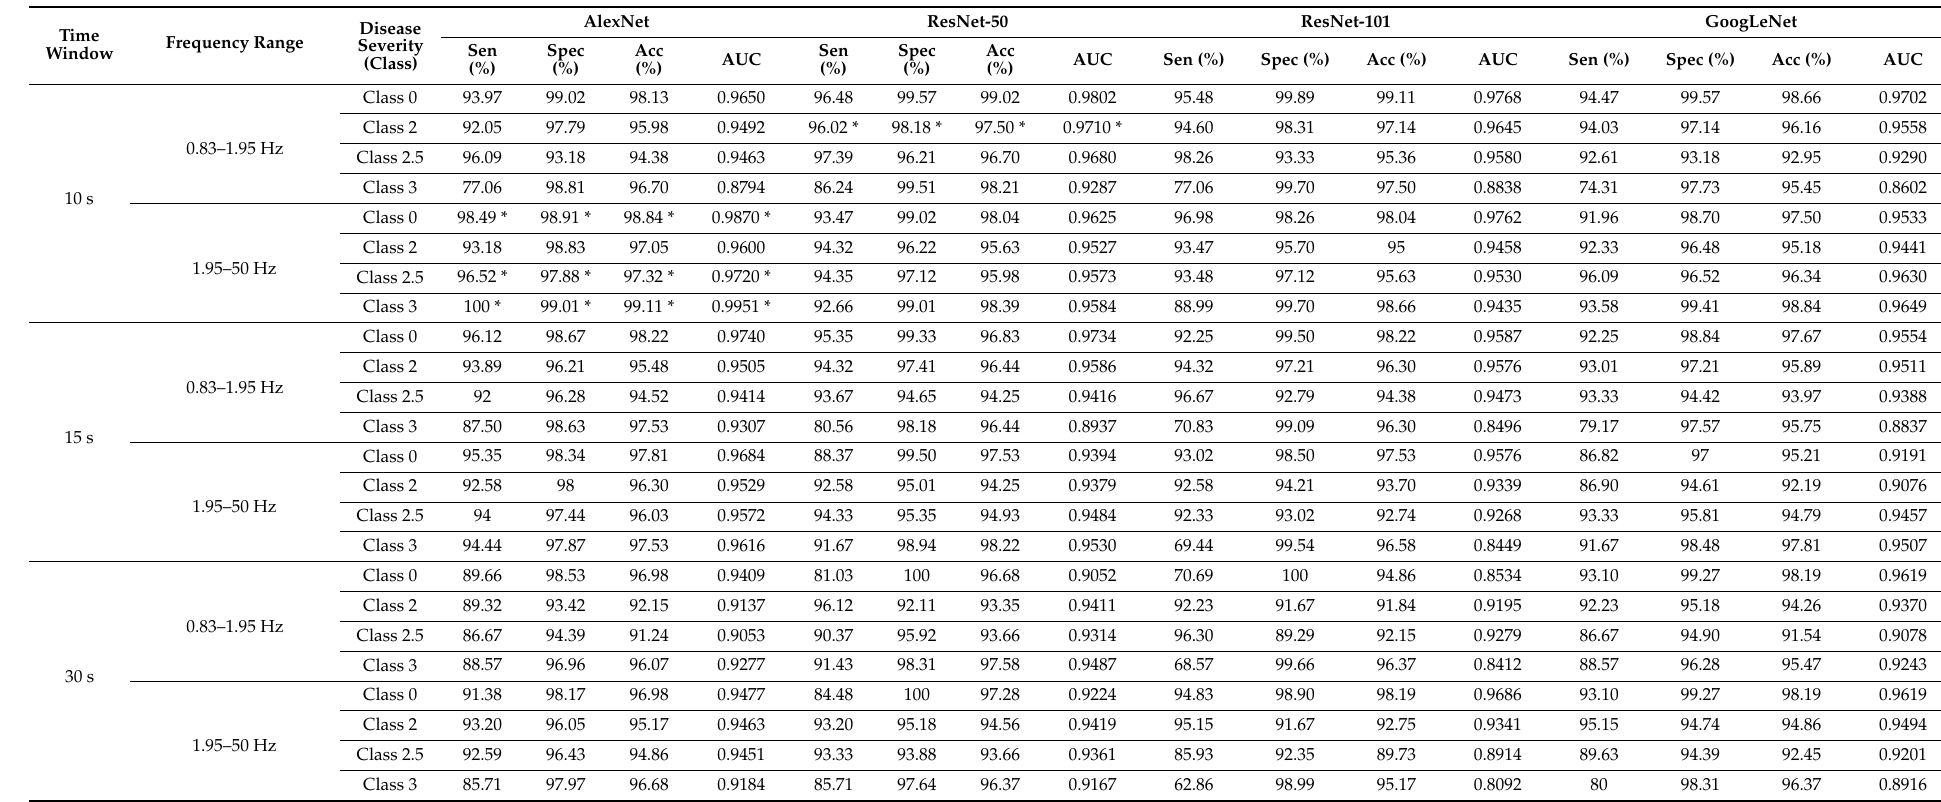
Table 12. Multi-class classification of CF from Ju dataset for CO (Class 0), PD Stage 2 (Class 2), PD Stage 2.5 (Class 2.5), and PD Stage 3 (Class 3) using several CNN classifiers (AlexNet, ResNet-50, ResNet-101, and GoogLeNet) with 10-fold